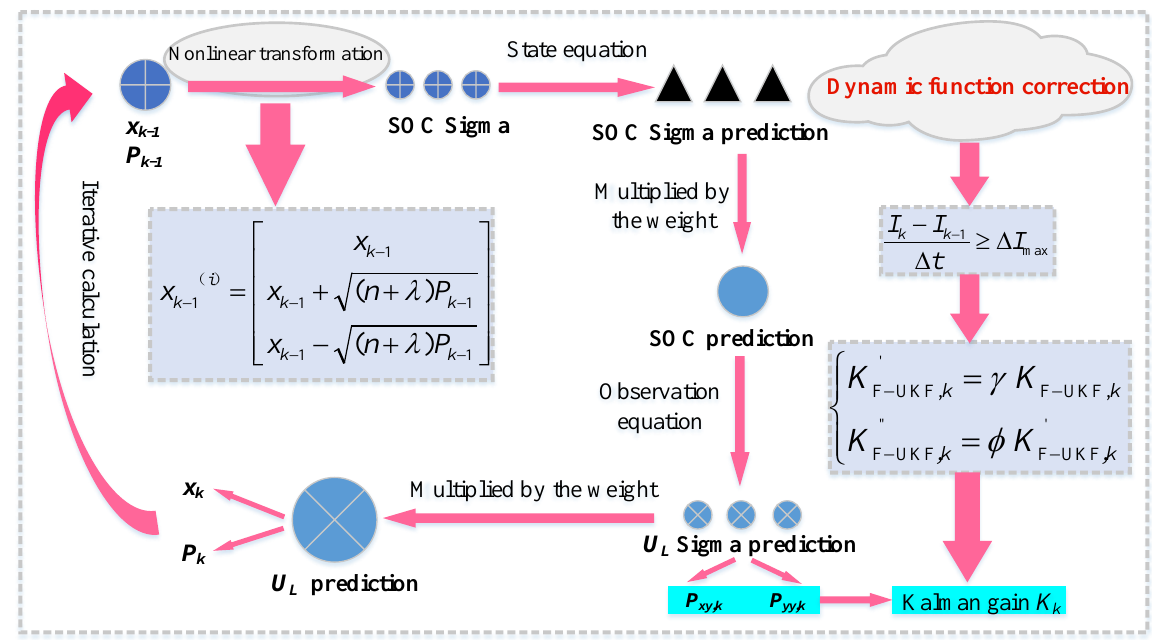
Figure 4. F-UKF algorithm iteration principle diagram.